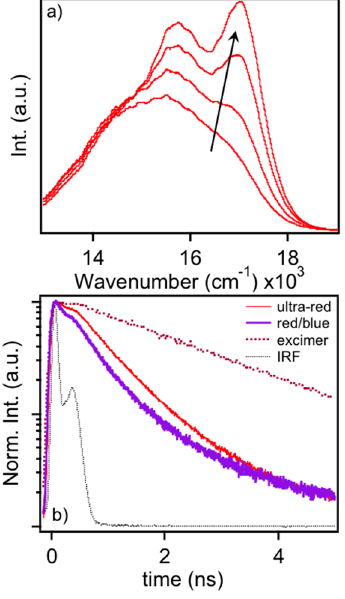
Figure 7. ( a ) PL spectra of an MEH-PPV thin film upon application of solvent vapor annealing; and ( b ) PL decays of single molecule MEH-PPV emitting species. Corresponding PL decay of an annealed thin film displaying excimer type emission is also included. Arrow